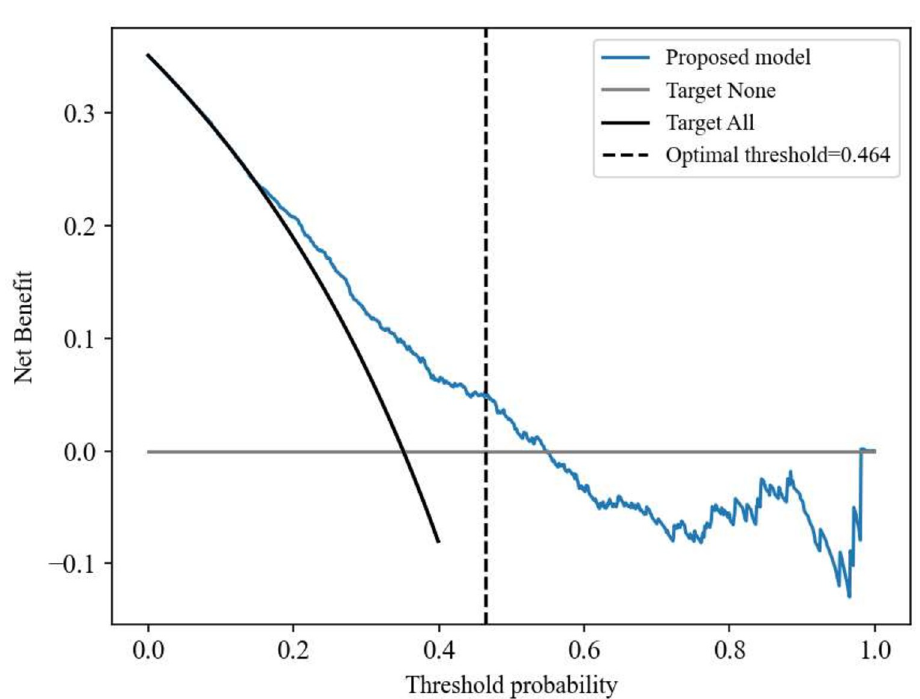
Fig 3. Decision curve analysis for the standardized net benefit obtained from the proposed ML model. The DCA (Decision curve analysis) showed the net benefit obtained from the ML (blue line) prediction model compared to the target all (solid black line) or target none (solid grey line). Net benefit by implementing our model in a clinical setting is larger when compared to the follow-up of all GDM women for ppGT. DCA was derived from the equation, Net � �h i benefit = 1 , where TP and FP are the true positives and false positives respectively, p TP (cid:0) FP p t 1 (cid:0) p t N probability threshold, and N is the total number of participants in the validation cohort, N =